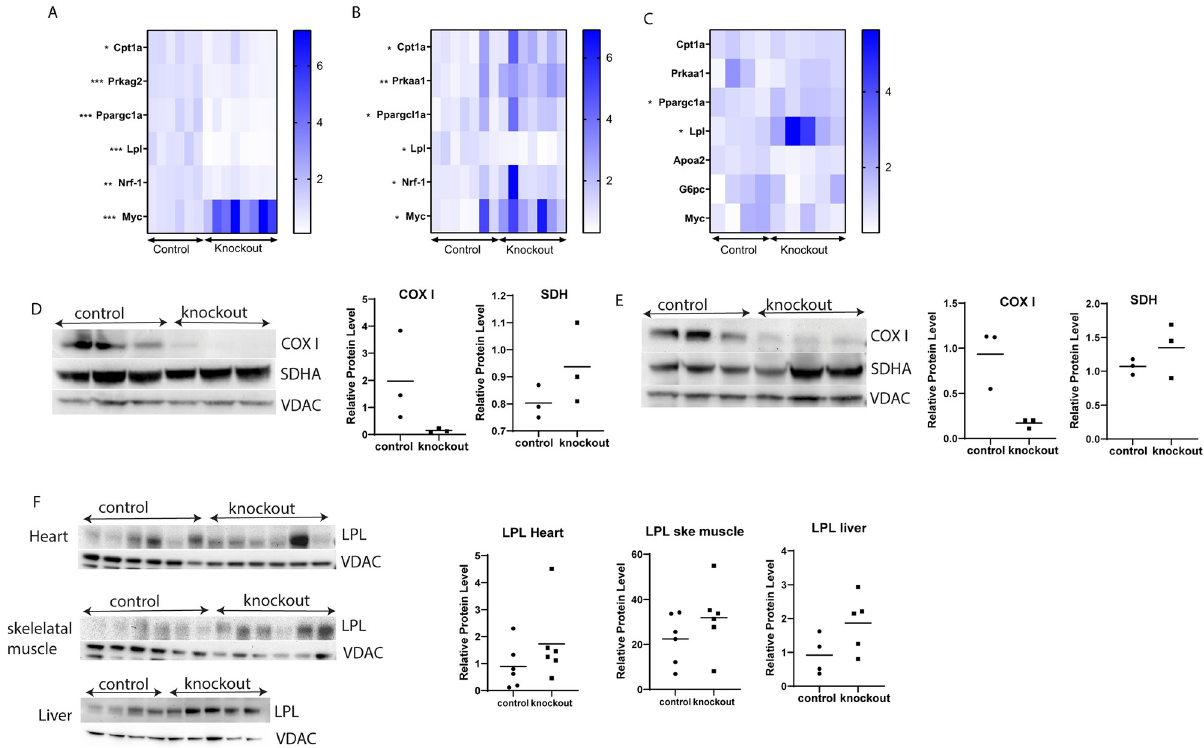
Fig 4. Gene expression in 16 weeks old Tk2 KO mice. (A) 16 weeks mice heart gene expression. n = 6 mice for control group, and n = 8 mice for knockout group. (B) 16 weeks mice skeletal muscle gene expression. n = 7 mice per group. (C) 16 weeks mice liver gene expression. n = 4 mice for control group, and n = 5 mice for knockout group. For (A-C), groups were compared using the Mann-Whitney U -test. (D) 16 weeks mice heart COX I and SDH protein level. (E) 16 weeks mice skeletal muscle COX I and SDH protein level. For (D-E), n = 3 mice per group. (F) 16 weeks mice heart and skeletal muscle LPL protein level. n = 4 mice for control group, and n = 5 mice for knockout group. For (A-F), groups were compared using Mann- Whitney U -test. Significant levels were set to p < 0.05( � ), p < 0.01( �� ), p < 0.001( ��� ).